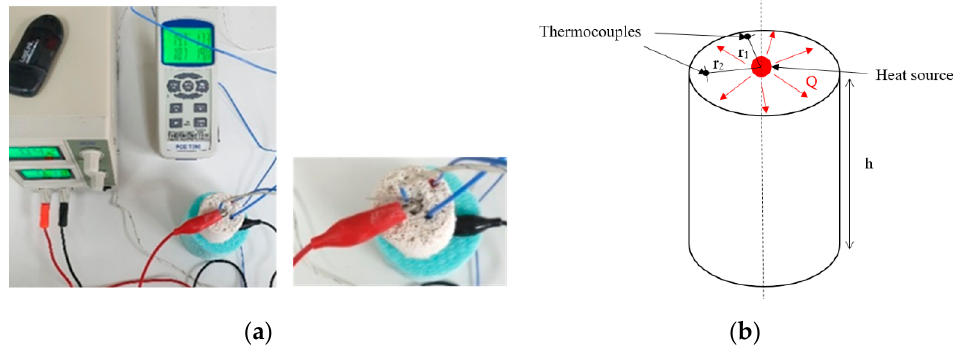
Figure 7. ( a ) Experimental setup for the measurement of thermal conductivity; ( b ) schematic of radial heat flow method. Based on Zhao et al. [35].